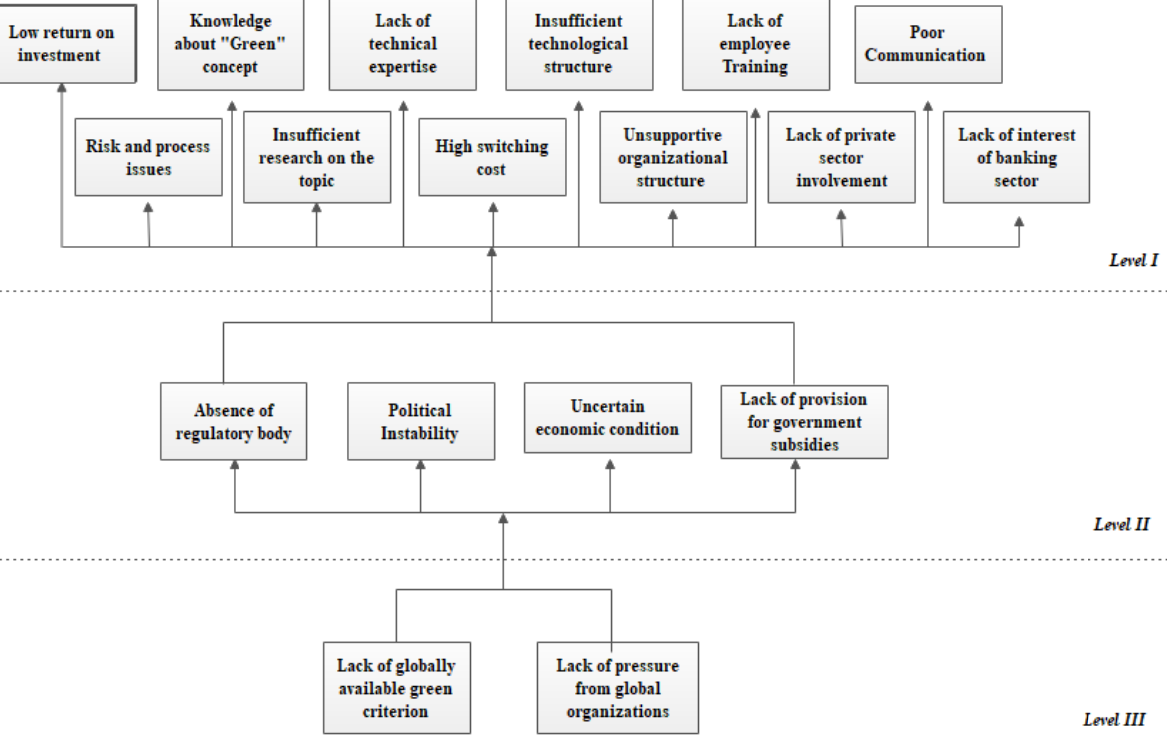
Figure 8. ISM Model for Barriers of Green